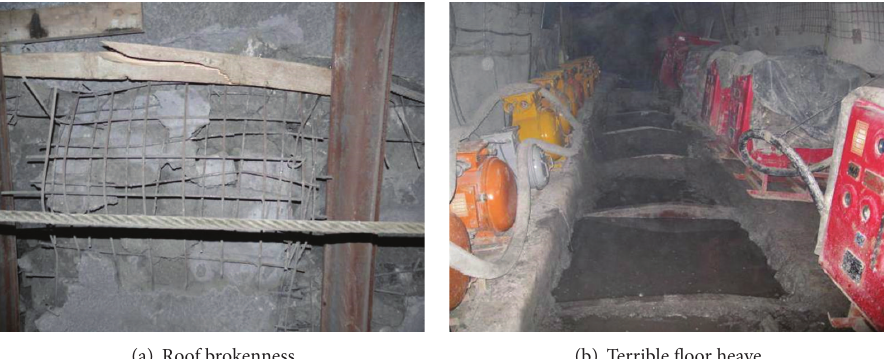
Figure 1: Tunnel failure in engineering site.